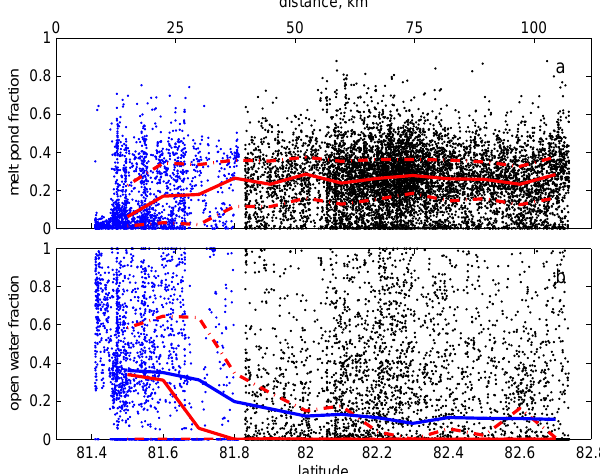
i mp (a) and f ow (b) summa- rized from the six flight tracks. Black dots highlight the f i mp and f i ow inferred from analysis of imagery from flights 1–5; blue dots are for the corresponding values from flight 6. Red solid and dashed lines show the moving median and the quartiles Q 1 , 3 , respectively, estimated in the window of 0.1 ◦ latitude width. For comparison the blue line in (b) also shows the moving average to highlight the skewness of the respective image-based probability